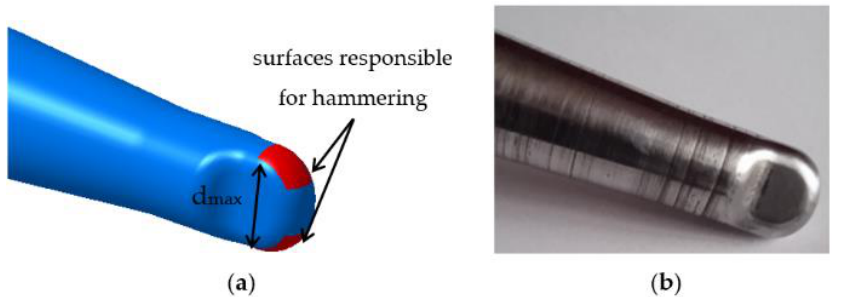
Figure 5. Circumferential hammering tool (CHT) active surfaces responsible for the circumferential hammering effect: ( a ) CAD 3D model; ( b ) real CHT.